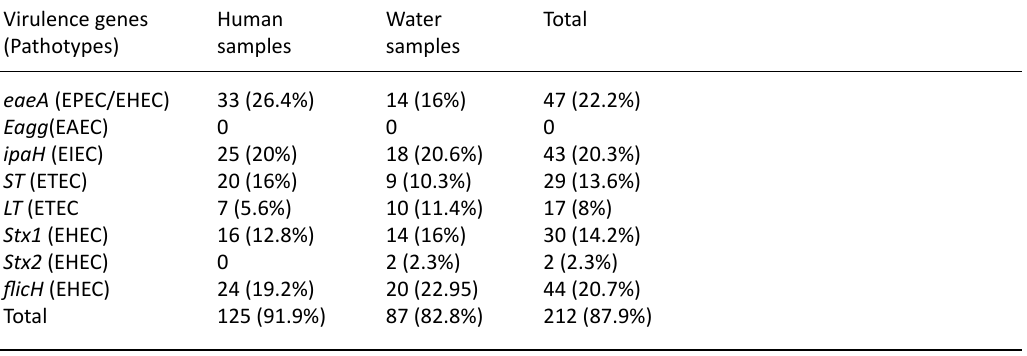
Table 3. Distribution of E. coli pathotypes among human and water samples Virulence